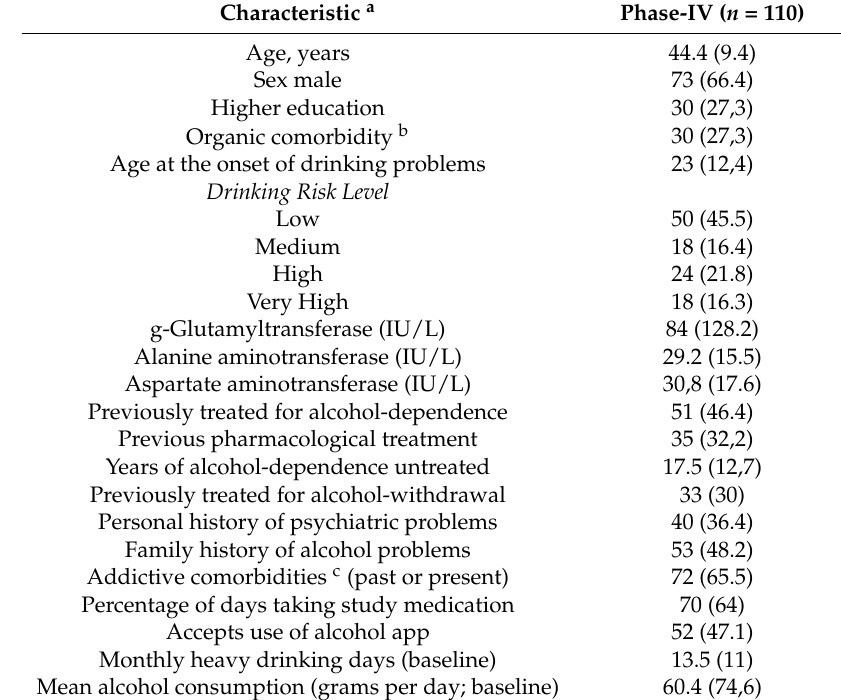
Table 1. Baseline sociodemographic and clinical characteristics of included